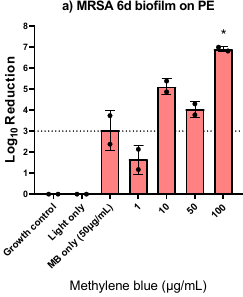
Figure 3. Photodynamic inactivation of six-day-old biofilms of methicillin resistant Staphylococcus aureus ( a ), Escherichia coli ( b ), Staphylococcus epidermidis ( c ), and Cutibacterium acnes ( d ) formed on polyethylene (PE) discs using different concentrations of methylene blue (MB). The bars show the average log 10 reduction with the standard deviation from two or three independent biological replicates. The dotted line signals a bactericidal effect (3 log 10 reductions). The stars (*) above the bars indicate 100% killing, i.e., no regrowth. MB only controls were performed with the determined minimum bactericidal concentration without regrowth (MBC 100% ).